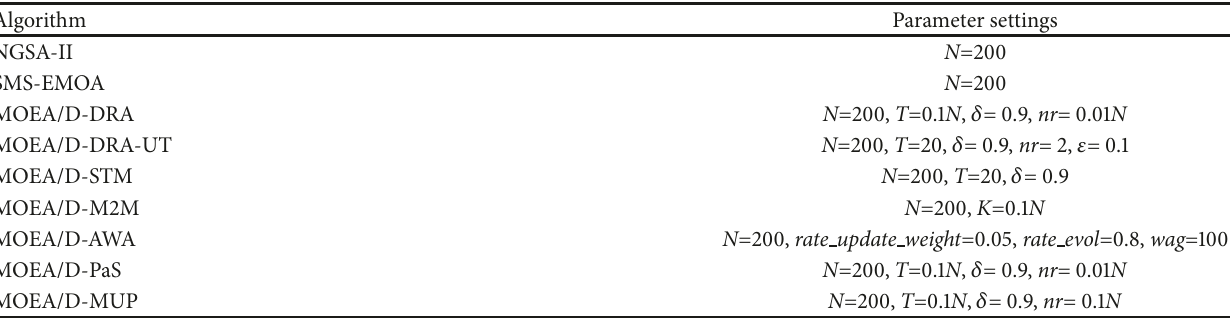
Table 1: Parameter settings of all the compared